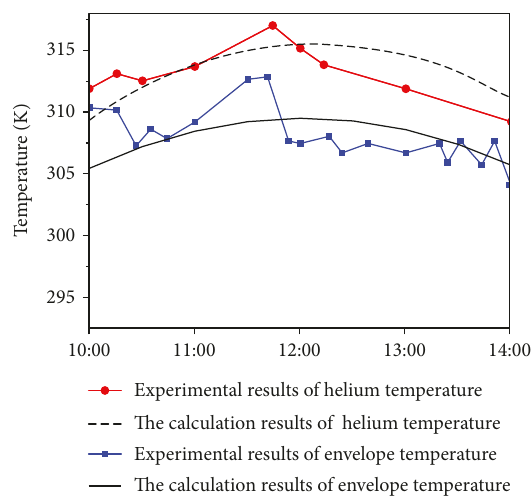
Figure 2: Comparison of the calculation and experiment